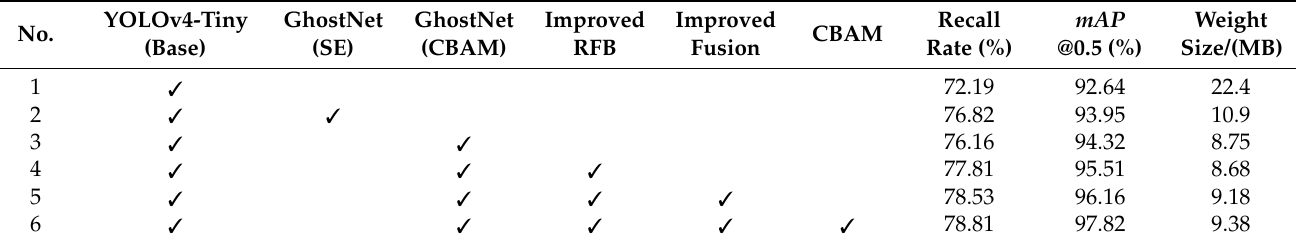
Table 2. Ablation experiments of PMD-YOLO.